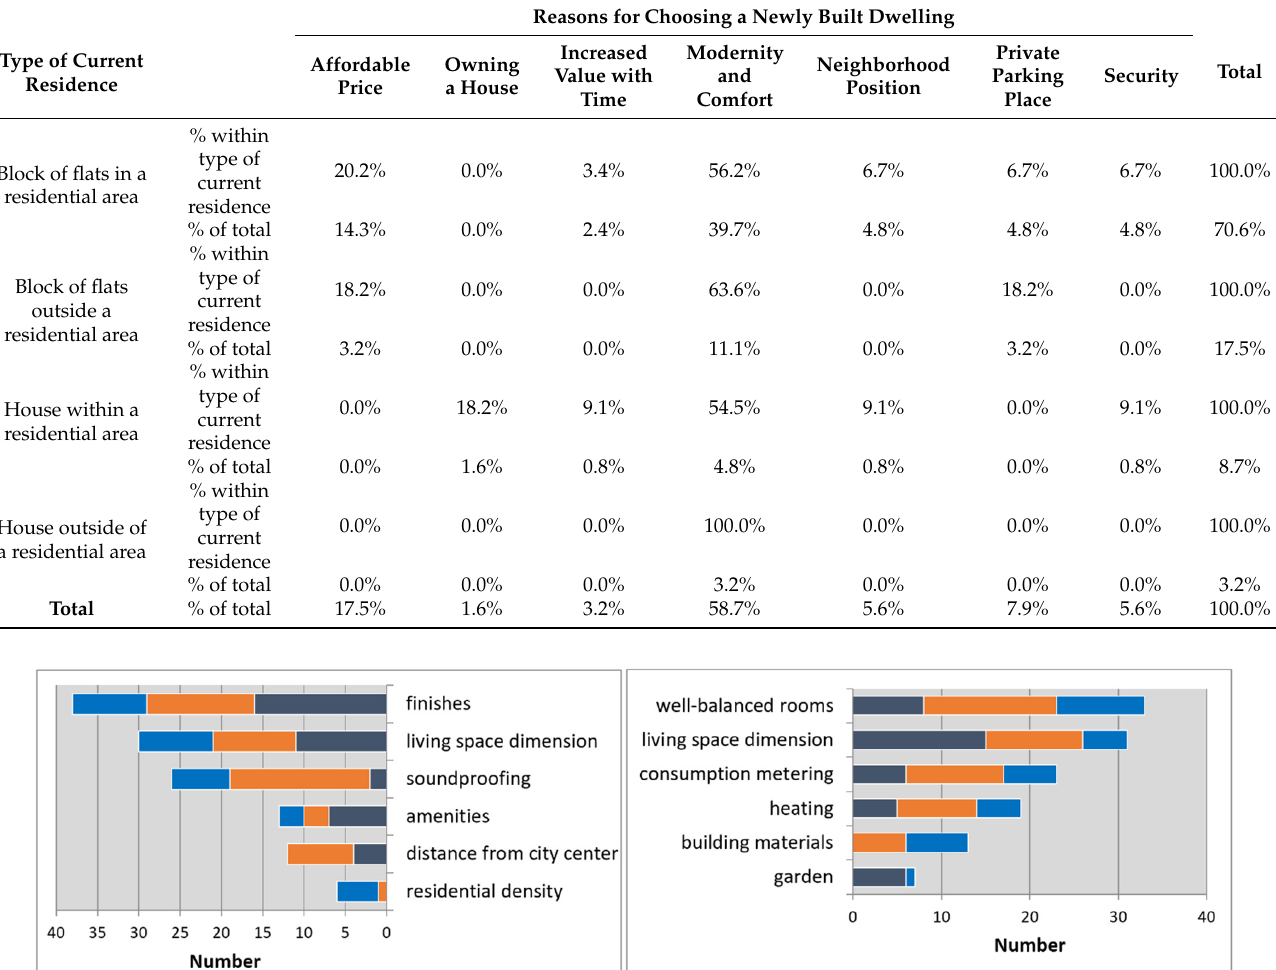
Table 6. Reasons for choosing a newly built dwelling by the type of current residence cross-tabulation.